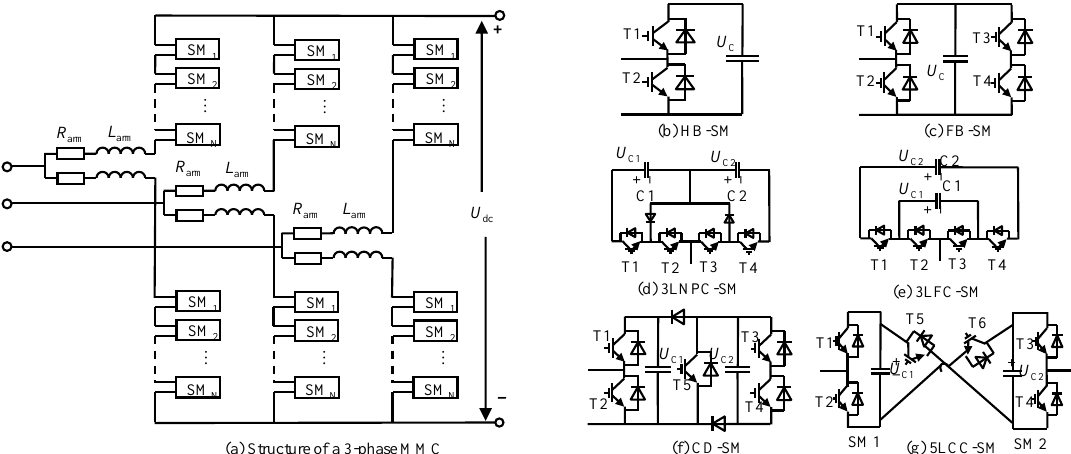
Figure 2. Structure of a three-phase MMC with various sub-modules